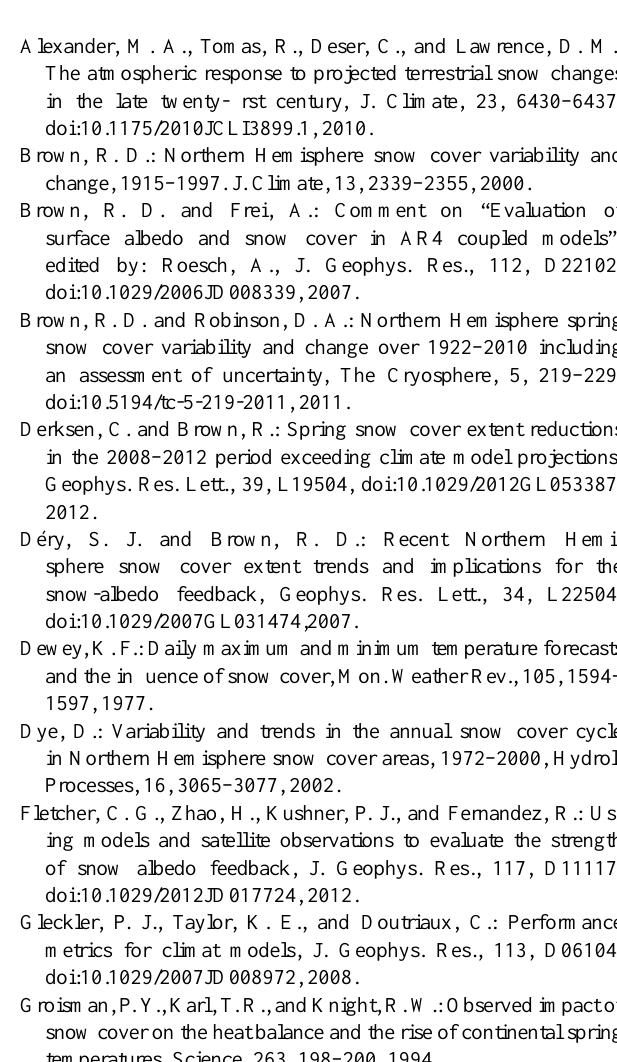
interference with the climate system (e.g. Meinshausen et al.,